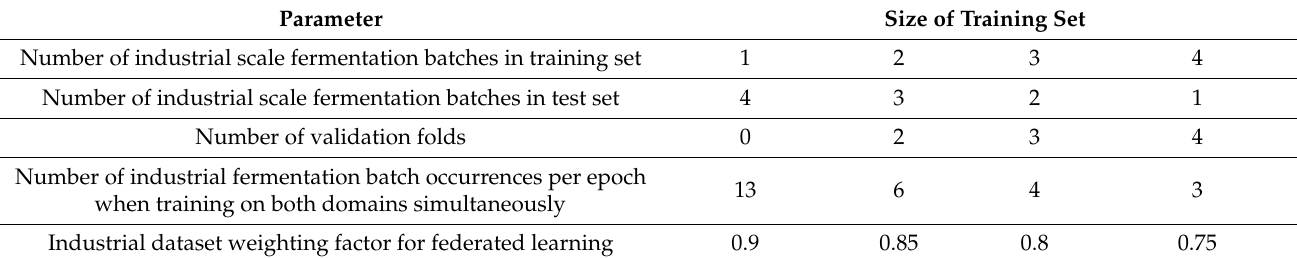
Table 2. Selected parameters for the domain adaptation networks depending on number of industrial scale fermentation batches in the training